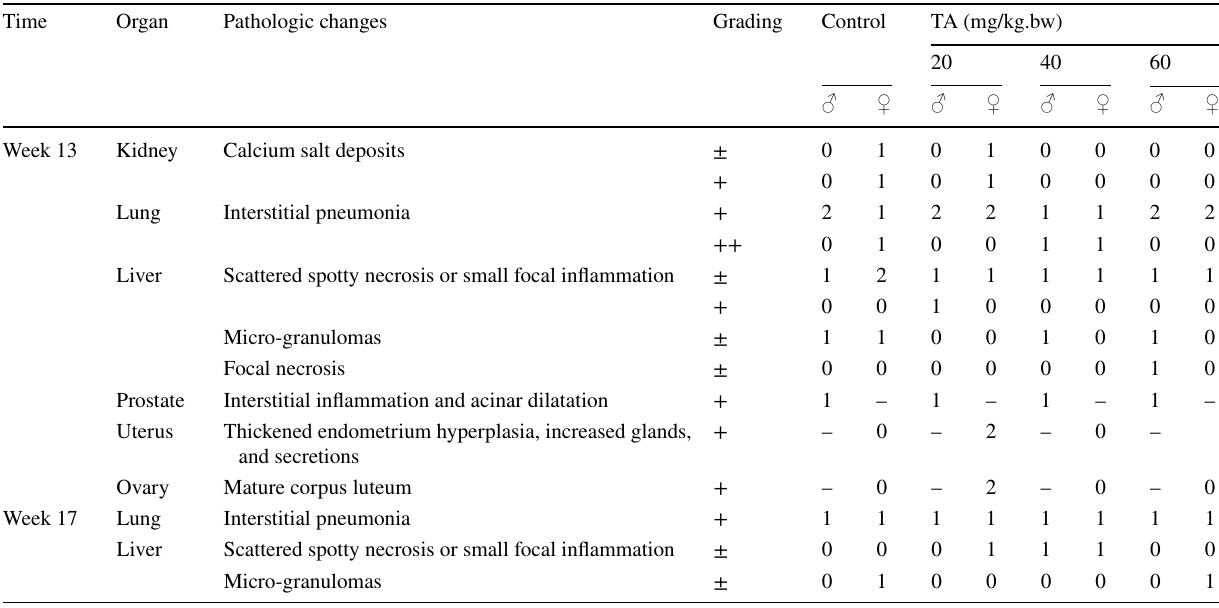
Table 2 Summary of histopathological findings